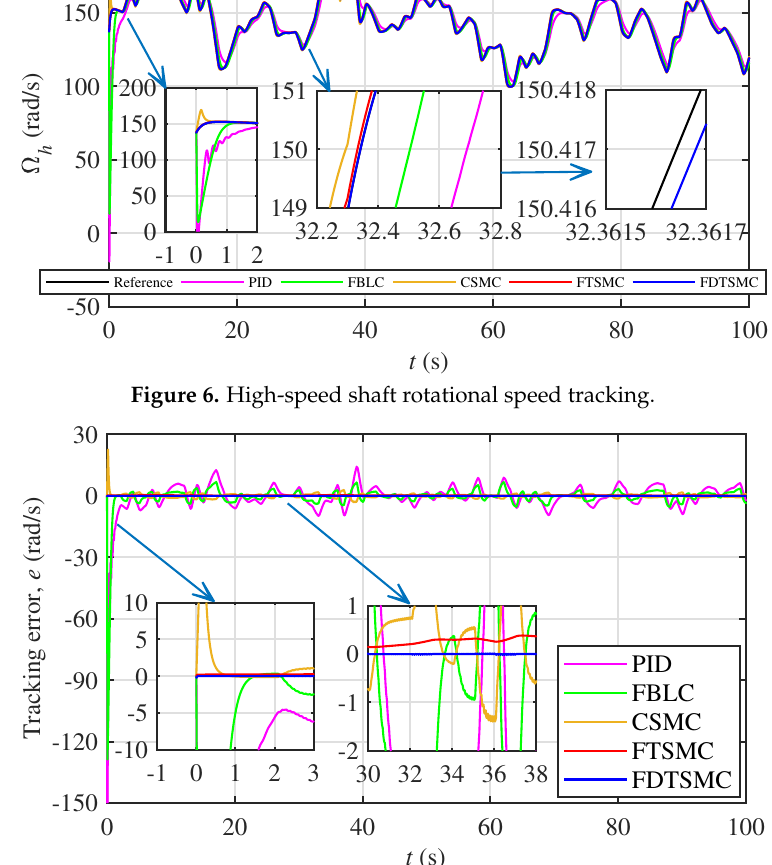
Figure 7. High-speed shaft rotational speed tracking